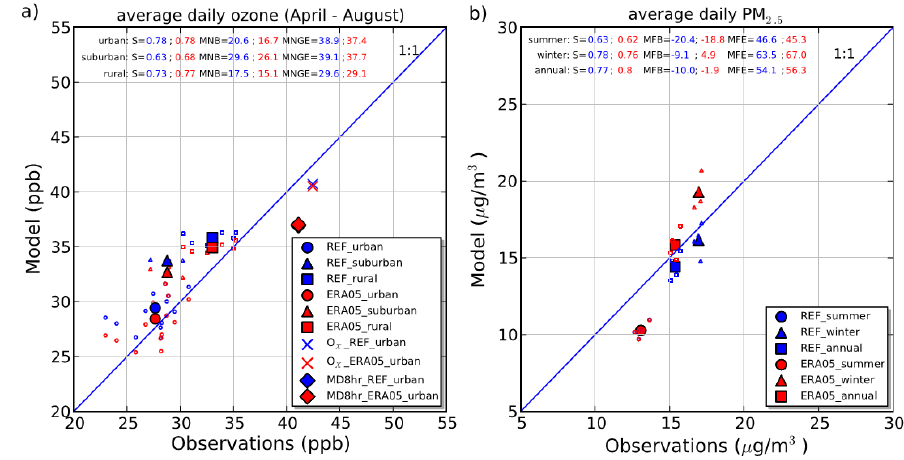
Figure 4. Scatter plots and scores for the sensitivity test on climate-model-driven meteorology for ozone and PM 2 . 5 . Table 3. Absolute difference (and percentage in parenthesis) between daily averaged ozone (ppb) and PM 2 . 5 (µgm − 3 ) from two climate- forced air-quality runs. The most influential factor for each sensitivity test is marked in bold. Ozone Urban Suburban Rural Climate meteo (REF vs. ERA05) 1.0 (3.4%) Meteo. resolution (ERA05 vs.